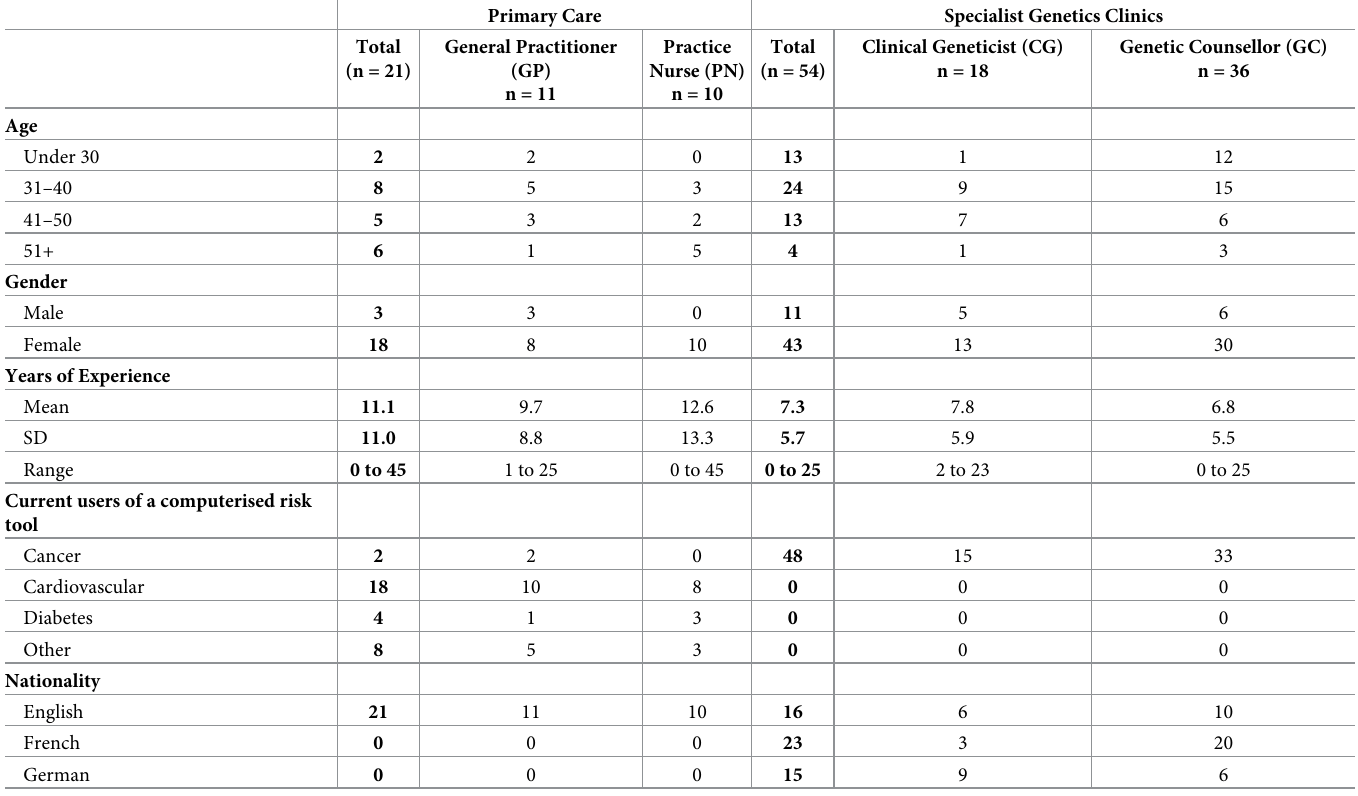
Table 3. Participant